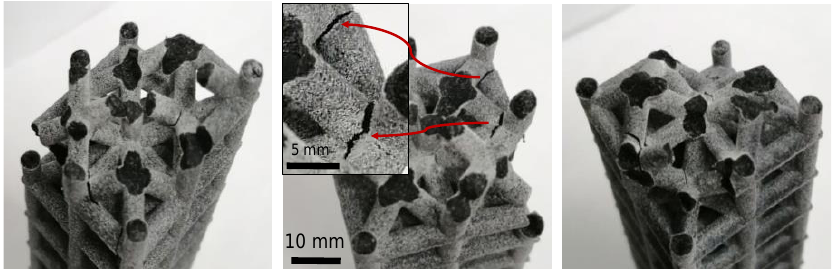
Figure 5. The figure shows an inner inclined structure in which the outer beams failed from the middle point whereas the inner inclined beams failed at the point of intersection.